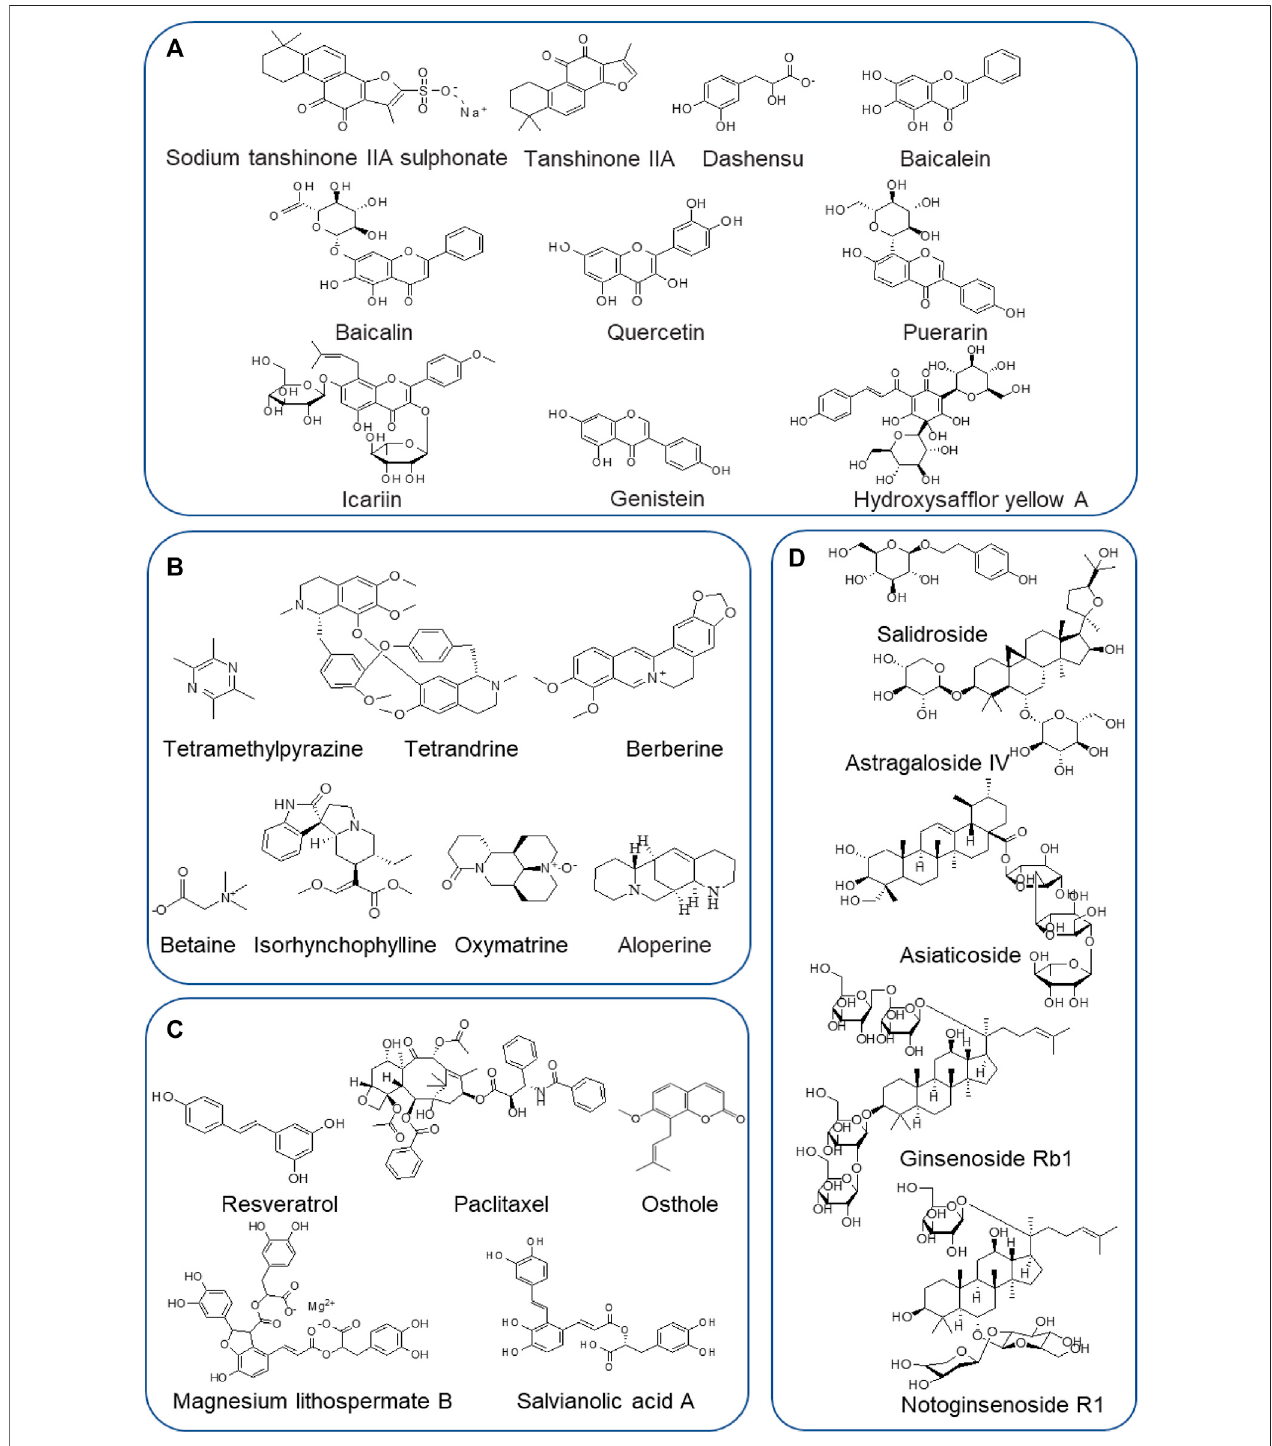
FIGURE 3 | Chemical structures of frequently studied THM-derived active components against PAH. (A) Flavonoids. (B) Alkaloids. (C) Phenolic acids. (D) Glycosides.